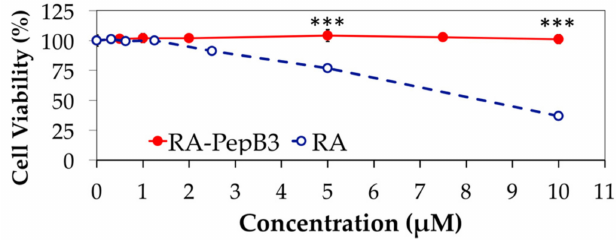
Figure 7. RVM Cell viability comparison between RA and RA-PepB 3 . Cell viability after treatment with varying concentrations of RA and RA-PepB 3 were assessed utilizing either PrestoBlue TM or Cell Counting Kit-8. N = 3; error bars depicted as SD; *** p < 0.001.